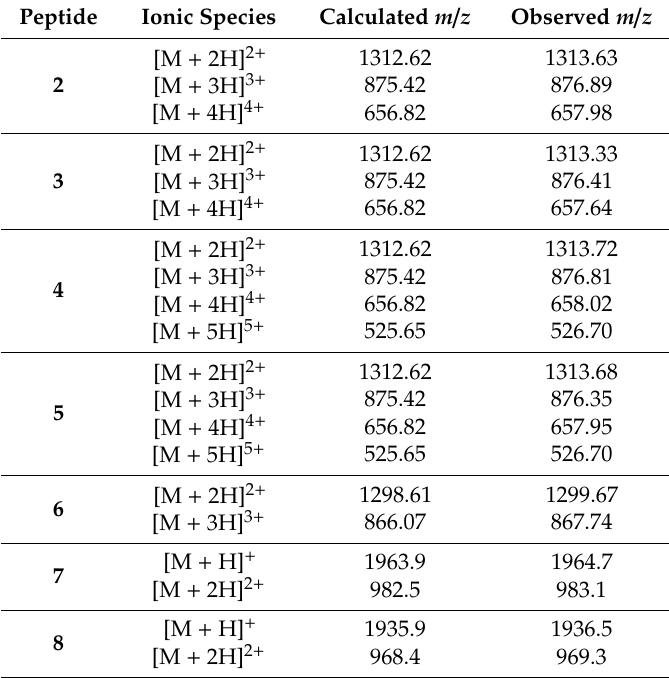
Table 1. MS analysis of peptides 2 – 8